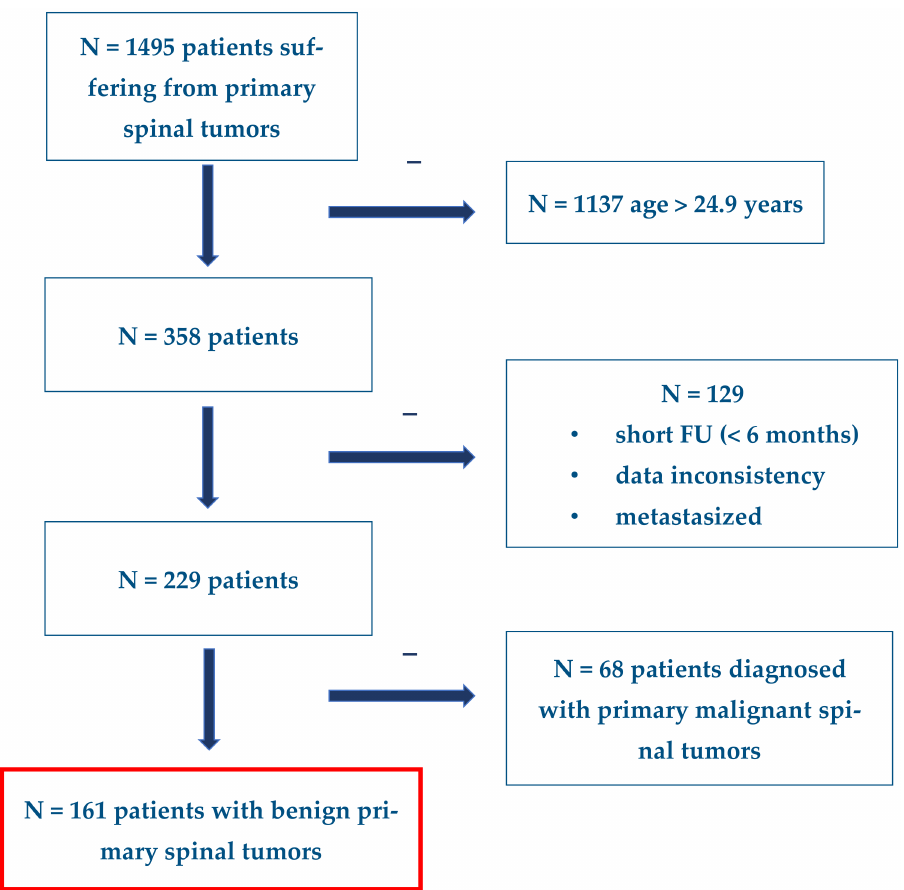
Figure 1. Flowchart of patient inclusion from the AO Spine Knowledge Forum’s PTRetro